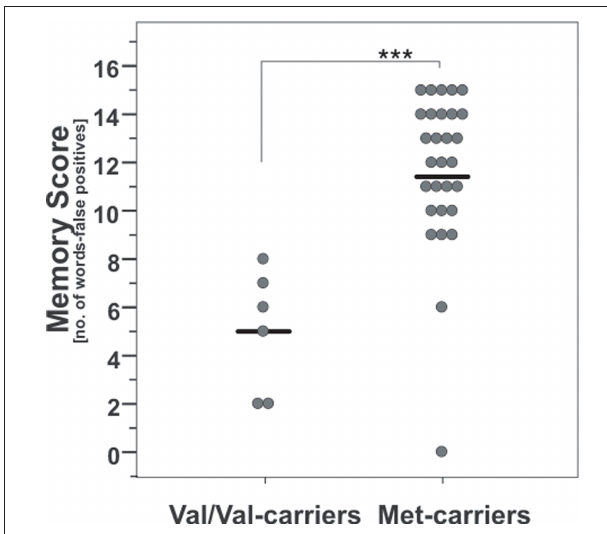
Figure 2 | Baseline memory scores according to COMT Val 158 Met genotype. Note that Val/Val -carriers had significant lower values than carriers of at least one Met -allele. ***, p = 0.001; according to unpaired t -test. Circles indicate individual values, solid lines indicate the mean.